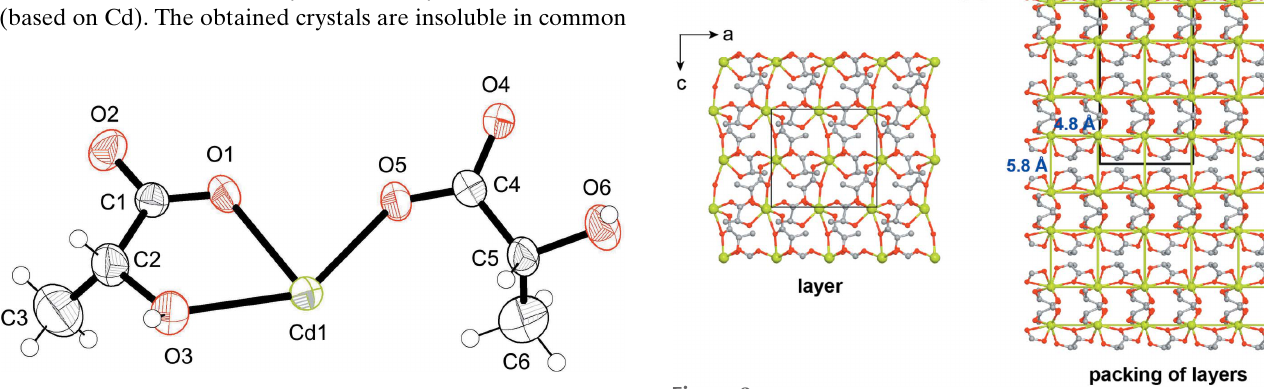
Figure 1 The asymmetric unit of the title compound showing the atom numbering with displacement ellipsoids drawn at the 50% probability